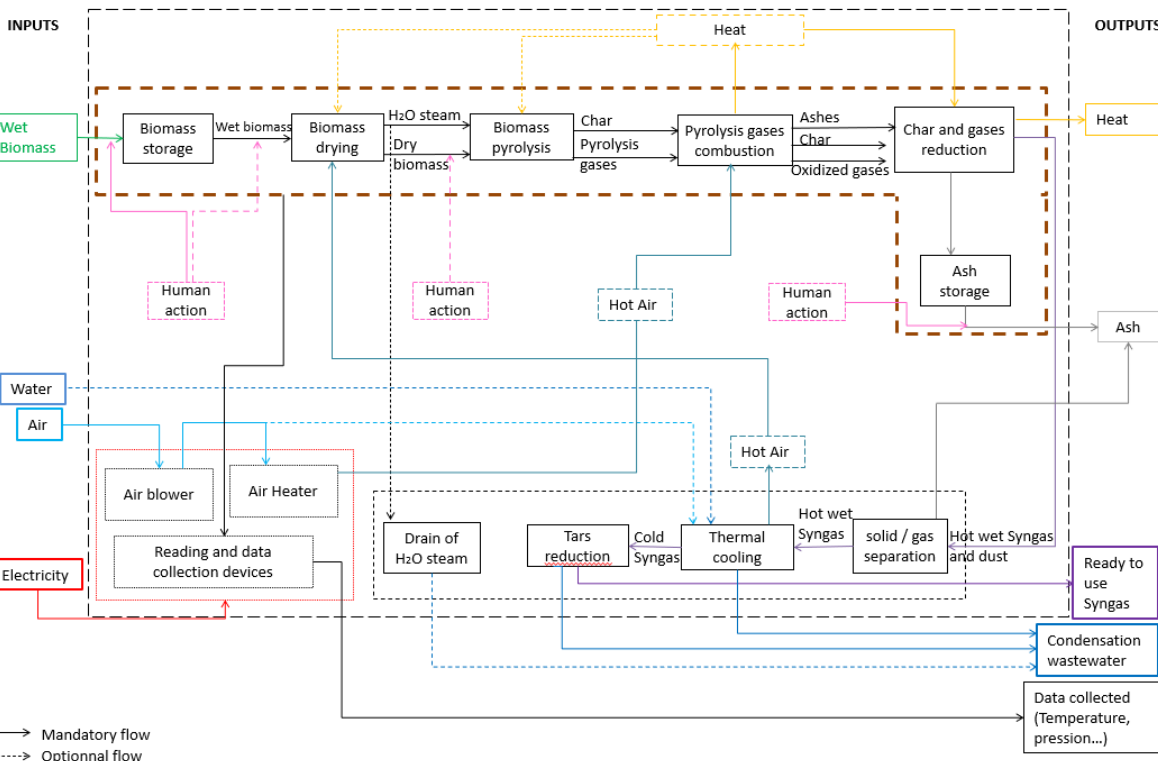
Figure 2. The functional analysis of the gasifier with the main gasification functions, the secondary treatment functions and the product flows between the functions.